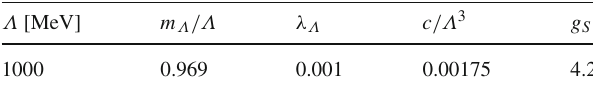
Table 1 Used parameter set [48]. It yields in the vacuum, for k IR = 80 MeV, the following observables: f π = 92 . 4MeV, m π = 137 . 6MeV, m σ = 606 . 7MeV and m q = 388 . 2MeV